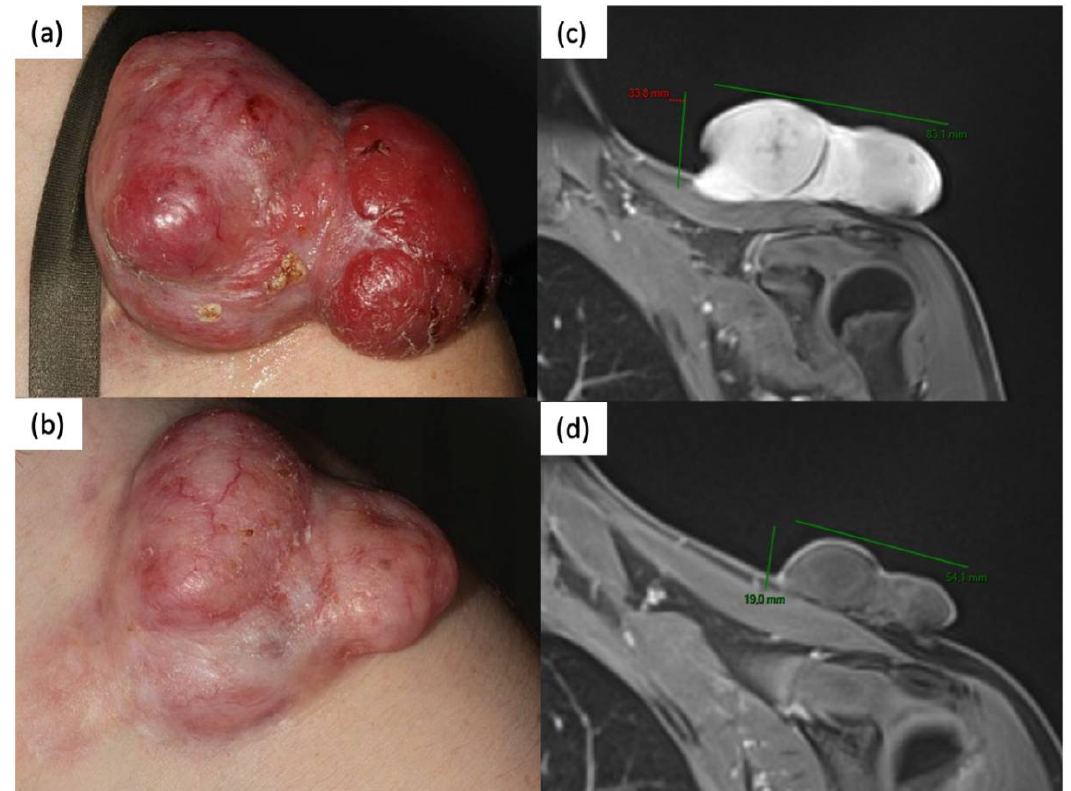
Figure 1. Patient with large DFSP located on the shoulder at baseline ( a ). Magnetic resonance imaging prior to the beginning treatment with imatinib mesylate ( c ). After 4 months therapy with imatinib, we observed a reduction of the tumor size ( b ) and of the signal intensity on MRI ( d ). Table 2. Tumor evaluation.